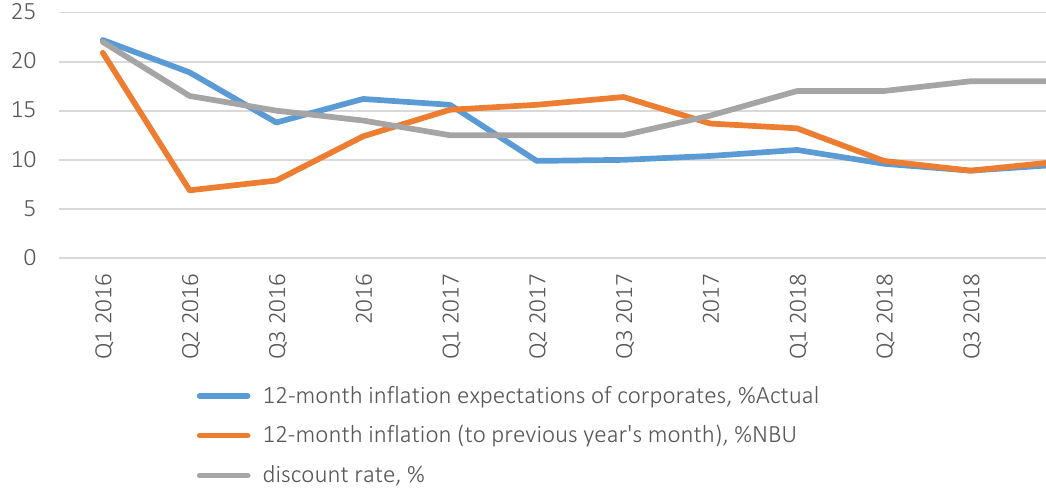
Figure 9. Expected and actual 12-month inflation, 2016–2018,